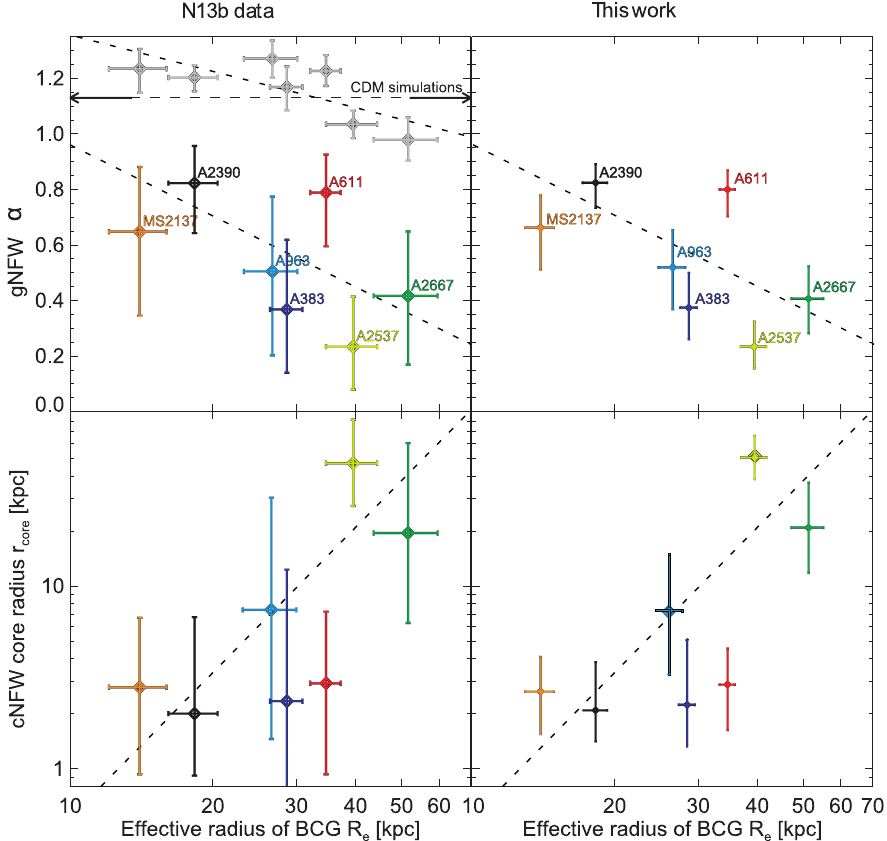
Fig. 2. Correlation among the inner DM pro(cid:12)le and the BCG size. Top left panel: gray points (region with (cid:11) > 0 : 9) represent the total density pro(cid:12)le presented in N13a, and the dashed horizontal line represents the mean slope in Gao et al. (2012) CDM-only simulations. The colored points are the (cid:12) vs. R e values for the clusters obtained using the gNFW by N13b. The dotted lines are the least-square (cid:12)ts. Bottom left panel: the core radii, r core of the cNFW model vs. R e . Top and bottom right panels: the same as the left panels but giving the results obtained by means of the model of this